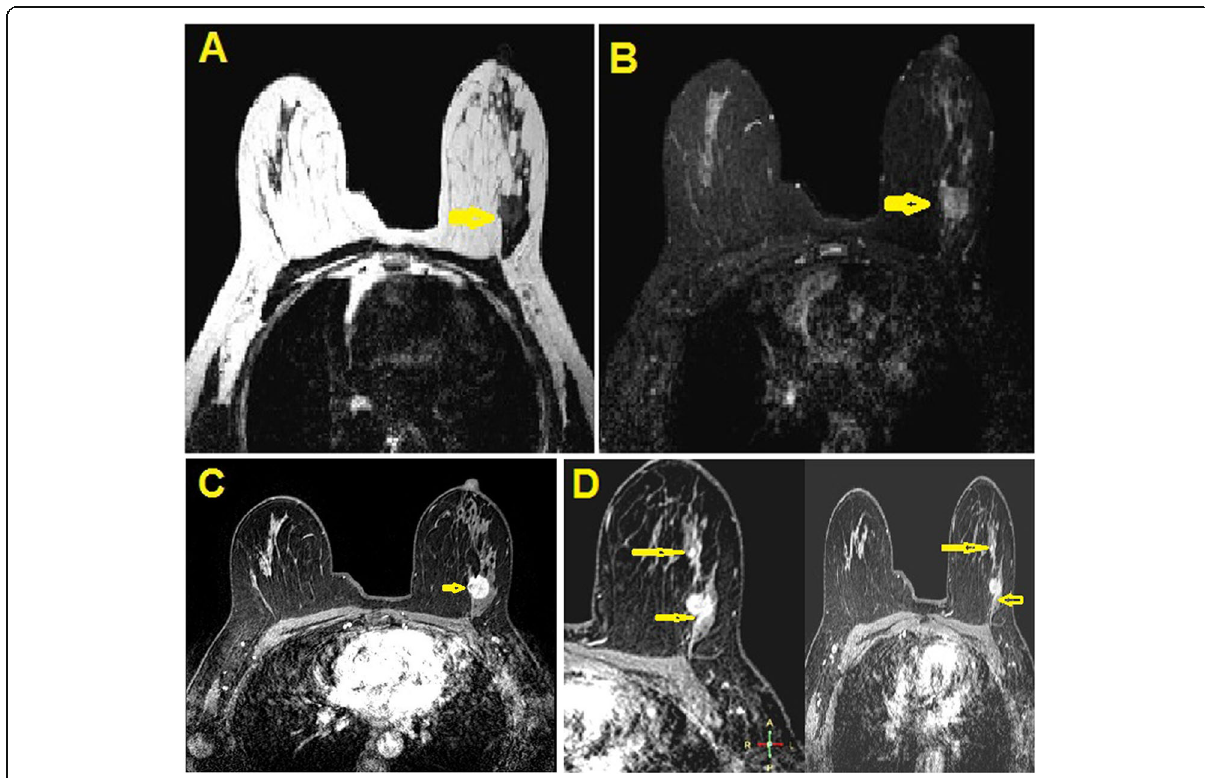
Fig. 2 MR images: a T2, b STIR, and c , d DCE-MRI post-contrast images. Left UOQ irregular non-circumscribed mass, eliciting intermediate-high T2 and STIR signal intensity “ arrow. ” It shows heterogenous enhancement in dynamic post-contrast images “ arrow. ” Left UOQ small linear non-mass lesion extending in front and behind the mass, eliciting bright T2 STIR signal intensity, and showing heterogeneous enhancement in dynamic post-contrast images “ arrowheads. ” Left UOQ enhancing focus “ arrow. ” The pathology revealed luminal B invasive ductal